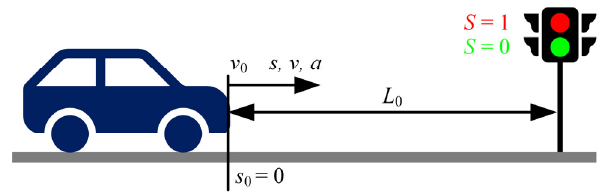
Figure 1. Traffic light crossing scenario schematic.